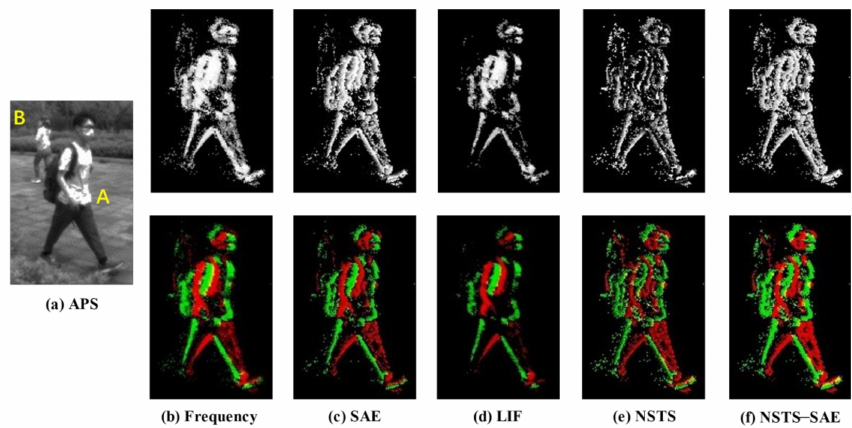
Figure 1. Comparison of the result of different event frame encoding methods. ( a ) The conventional grayscale frames were provided by the active pixel sensor (APS) channel of the DAVIS camera. Event-frame reconstruction from the dynamic vision sensor (DVS) channel by ( b ) frequency [10], ( c ) surface of active events (SAE) [15], ( d ) leaky integrate-and-fire (LIF) [18], ( e ) proposed neighborhood suppression time surface (NSTS), ( f ) proposed NSTS–SAE encoding method. Upper row: the representation by adding positive and negative polarity events (white represents the event, black represents the background). Bottom row: the individual representation of the positive and negative polarity events (red for positive, green for negative, and black for